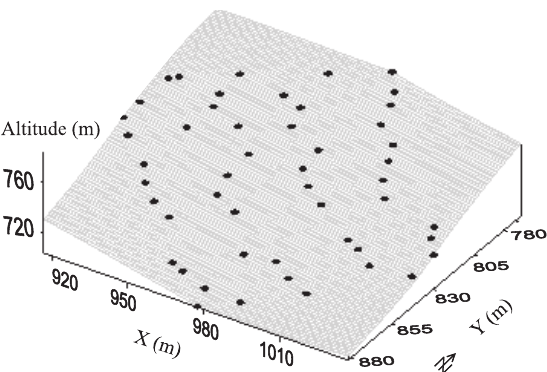
figure 1. digital elevation model (deM) of study area with the distribution of sampling